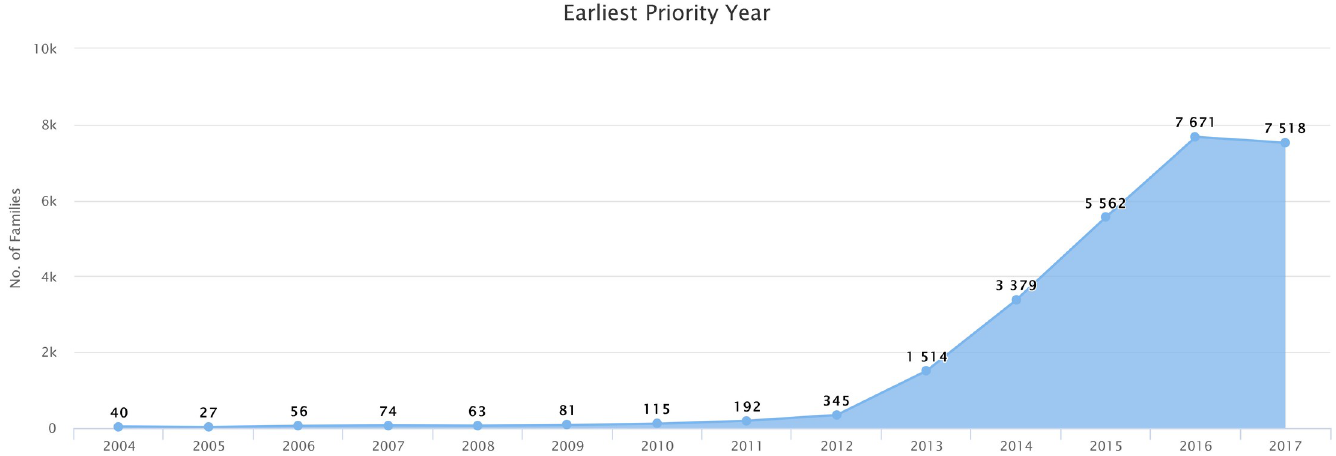
Fig 1. Evolution in the annual number of 3D printing technology patents (simple families) filed since year 2004. Screenshot of the number of patents filed each year since year 2004, retrieved by running the query presented in the “data download” section on the Patseer database (query run on 19 November 2018). The years on the x-axis correspond to the earliest priority year of the simple patent family. It should be noted that data corresponding to year 2017 might present a substantial amount of upside variation due to database updates.